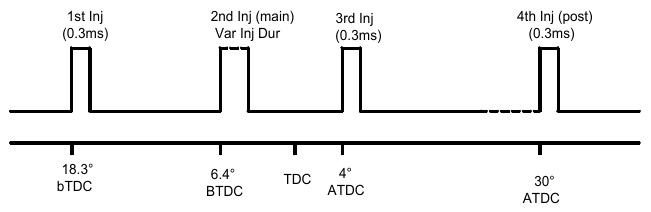
Figure 2. Injection timing diagram.